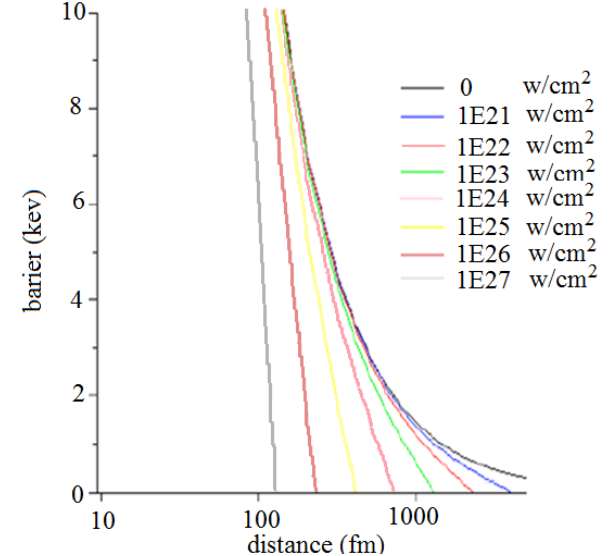
Figure 6. The details of the barrier potential around grand level with various